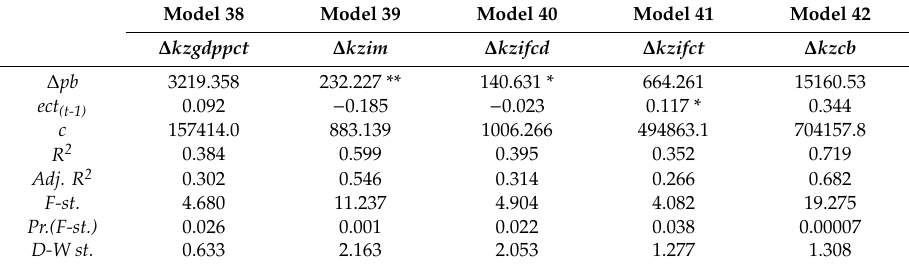
Table 7. The influence of oil price on macroeconomic indicators (Kazakhstan).